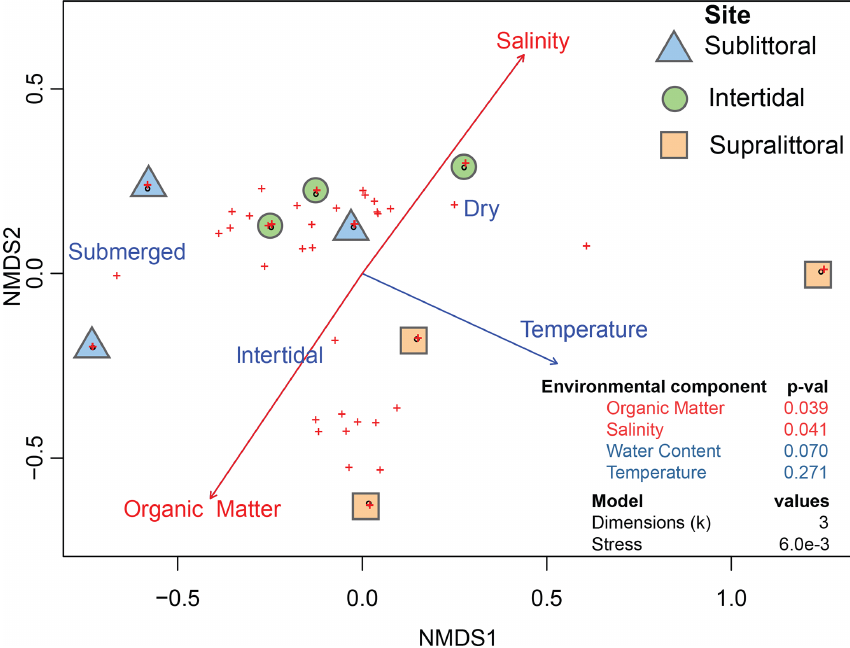
Figure 3. Correlation between environmental variables and prokaryotic communities. Dots represent taxonomic abundances per site as plotted by vegan metaMDS using nonmetric multidimensional scaling (NMDS). Arrow length is a representative of the predictor strength of environmental variable vectors, with red arrows having statistical significance as calculated by envfit ( p value < =